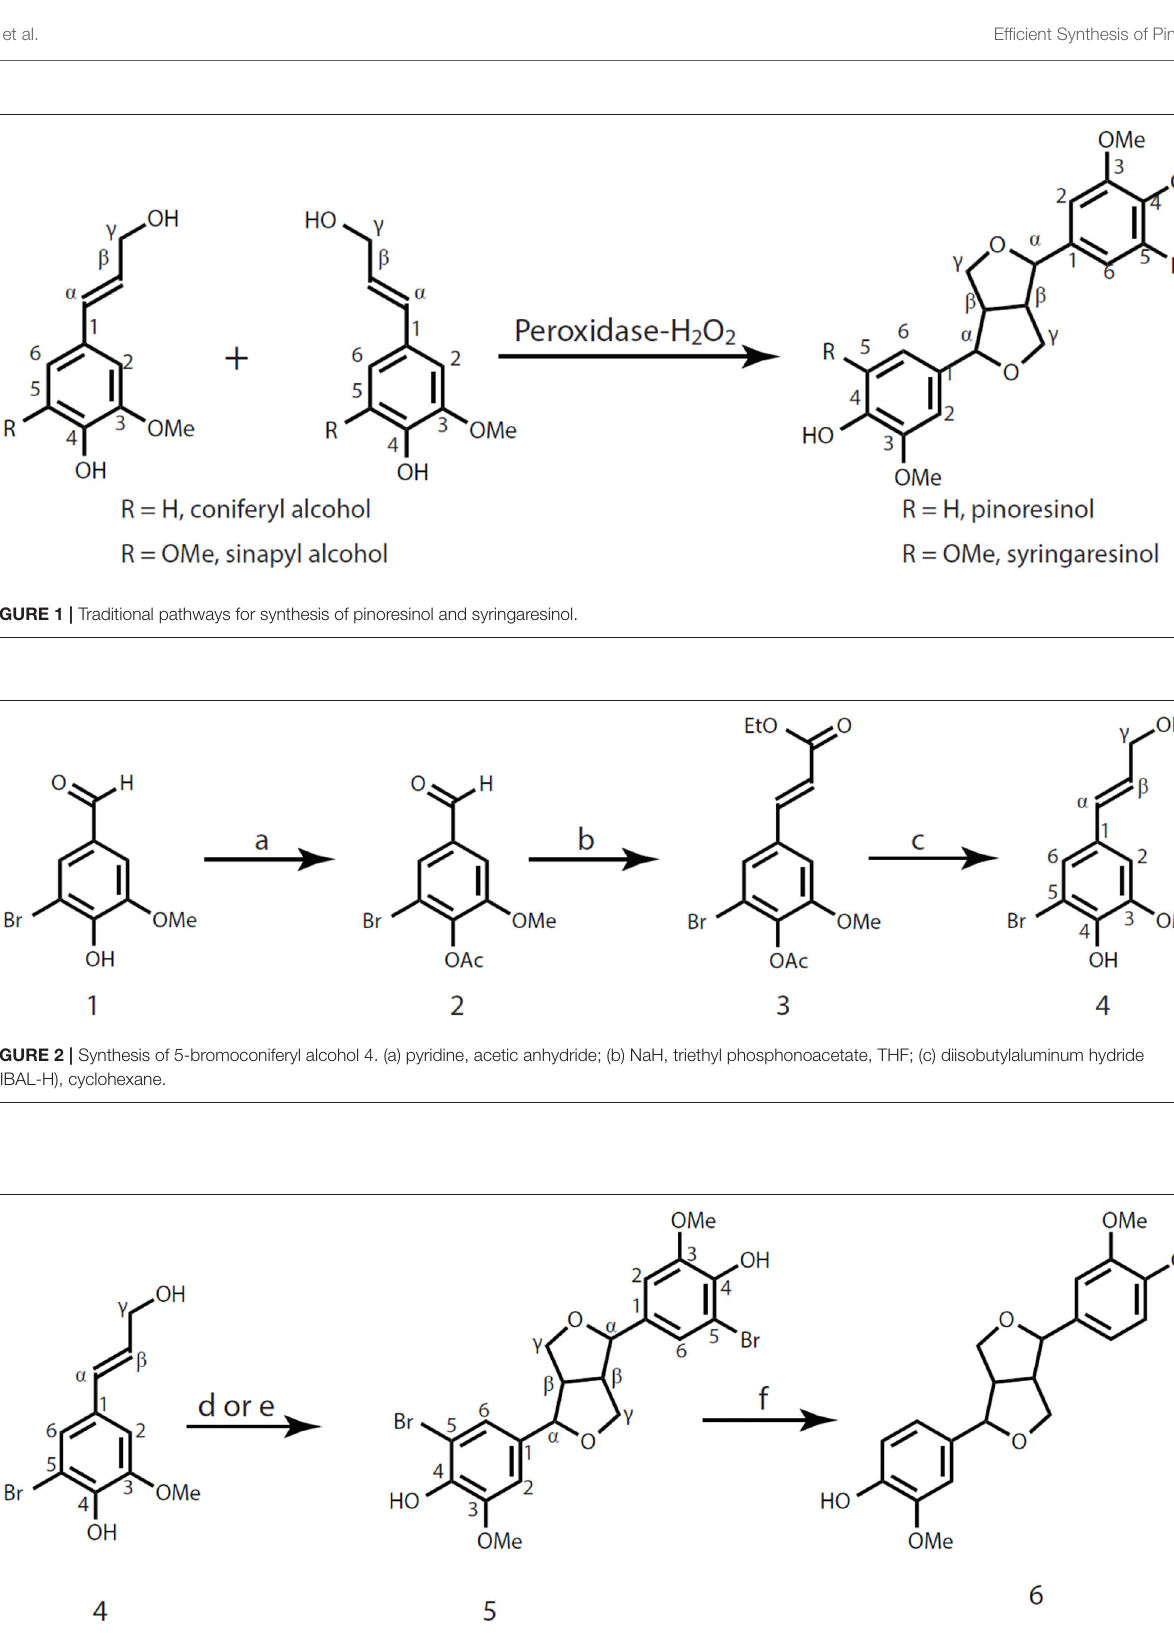
FIGURE 3 | Synthesis of pinoresinol from 5-bromoconiferyl alcohol 4. (d) H 2 O 2 , peroxidase; acetone-buffer; (e) FeCl 3 , acetone-buffer; (f) Et 3 N, Pd/C, H 2 , methanol.